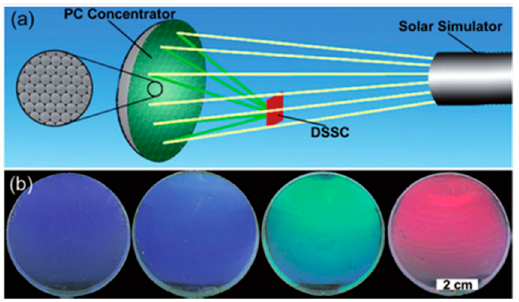
Figure 13. ( a ) Schematic illustration of the photovoltaic system with a photonic crystal concentrator. The insert is a SEM image of the photonic crystal concentrator. ( b ) Photographs of the PC concentrators with different colours [135].